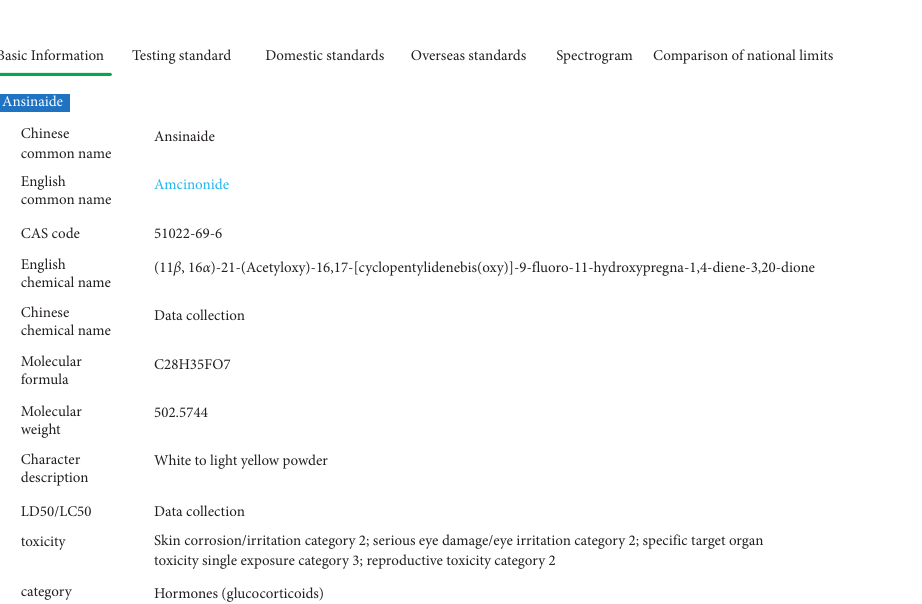
Figure 7: Compound basic information display